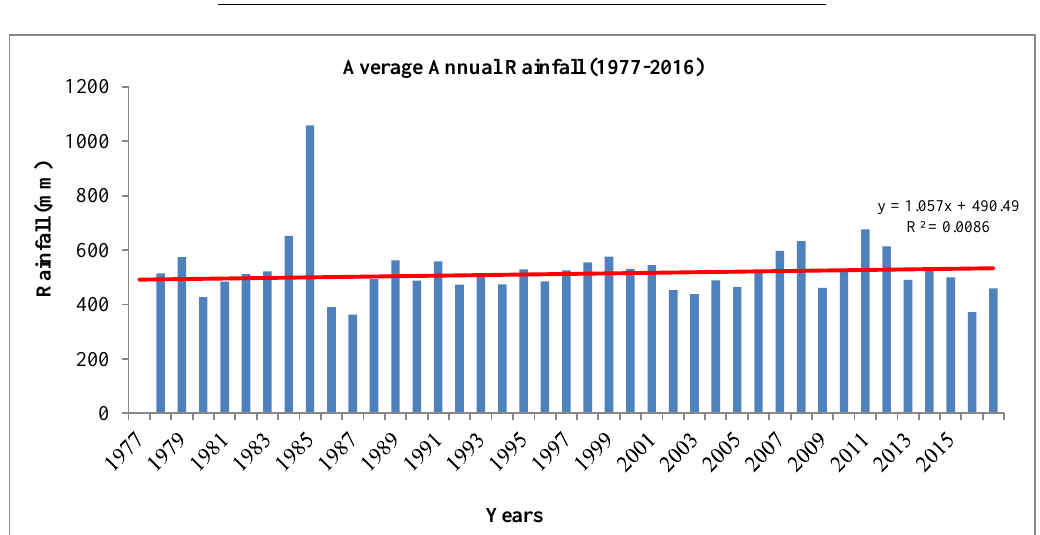
Figure 2. Average Annual Rainfall in the study